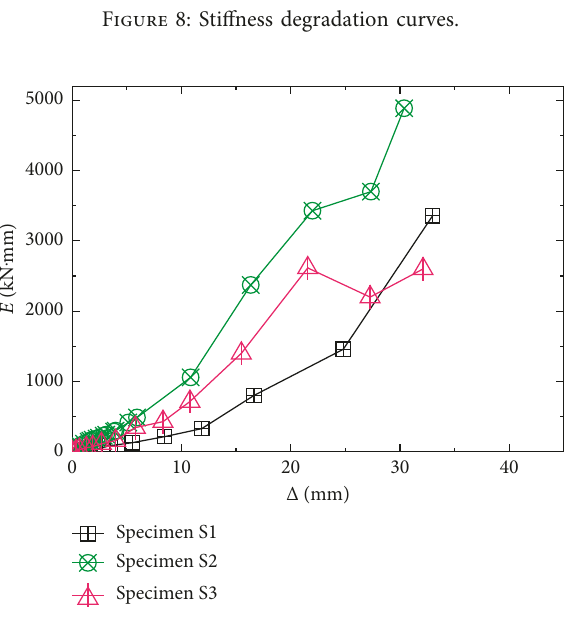
Figure 8: Stiffness degradation curves.